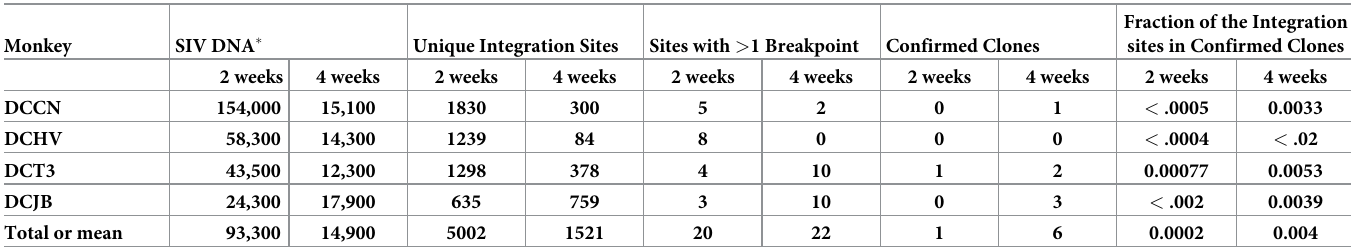
Table 9. Pretherapy PBMC viral DNA and integration sites. Monkey SIV DNA �